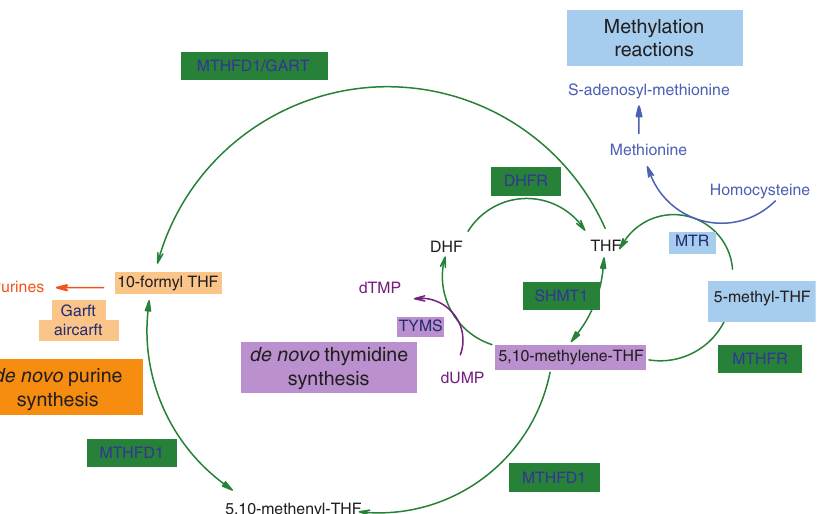
Figure 2: The folate-mediated one-carbon metabolic network. AICARFT, 5 ′ -amino-4 ′ -imidazolecarboxamide ribonucleotide transformylase; DHF, dihydrofolate; DHFR, dihydrofolate reductase enzyme; dTMP, deoxythymidine monophosphate; dUMP, deoxyuridine monophosphate; GARFT, β -glycinamide ribonucleotide transformylase; MTHFD1, C-1-tetrahydrofolate synthase; MTHFR, methylene tetrahydrofolate reduc- tase; MTR, 5-methyltetrahydrofolate-homocysteine methyltransferase; SHMT1, serine hydroxymethyltransferase; THF, tetrahydrofolate; TYMS, thymidylate